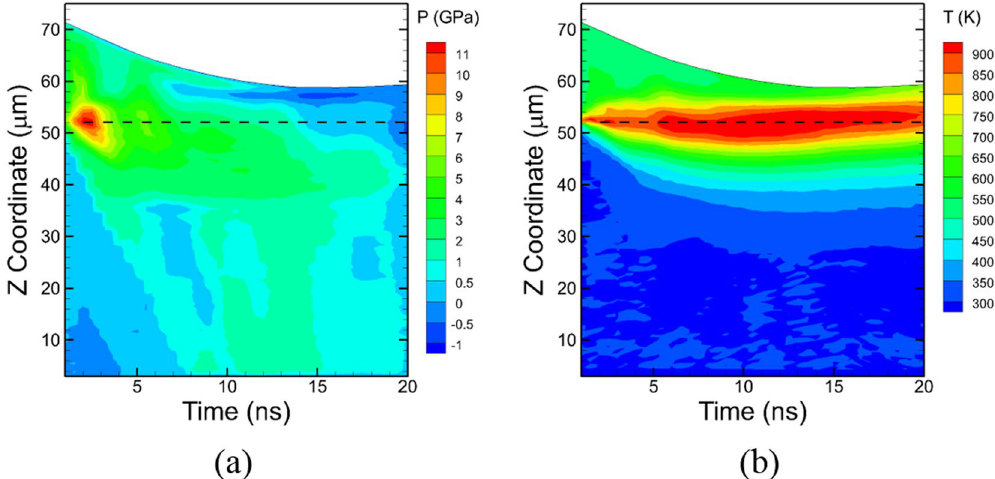
Figure 2. Evolution of average ( a ) pressure and ( b ) temperature generated in a thin vertical section through the center of the particle (for v i = 1600 m/s) and the substrate along the Z axis (See Supplemental Information